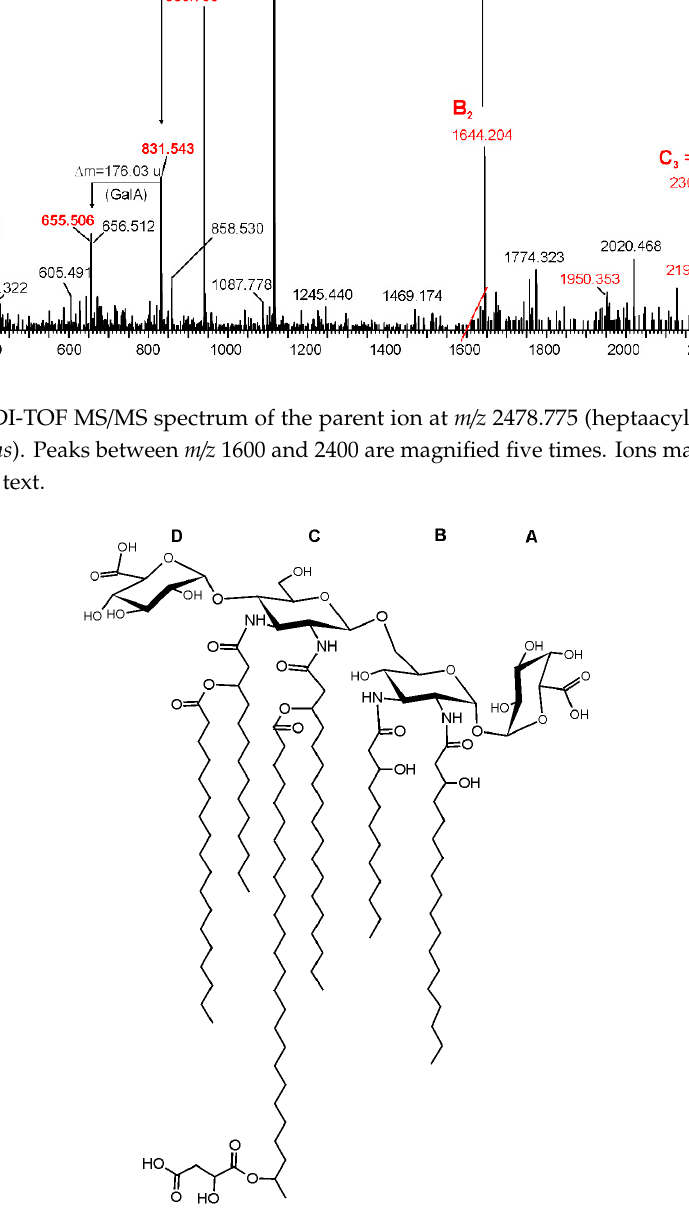
Figure 5. Proposed structural formula for the most complex O. carboxidovorans OM5 lipid A molecule. M mi = 2455.76435 u.